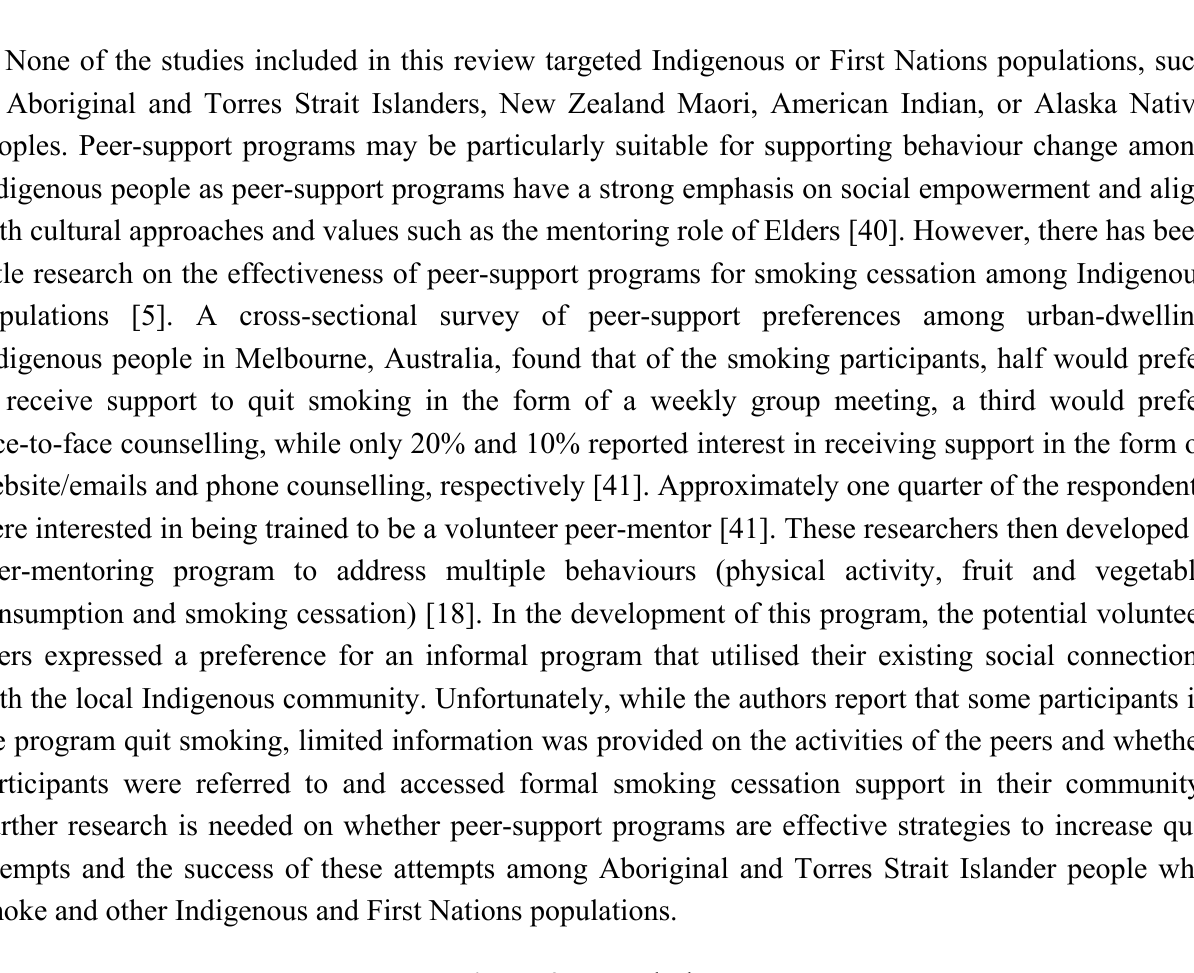
Figure 2. Funnel